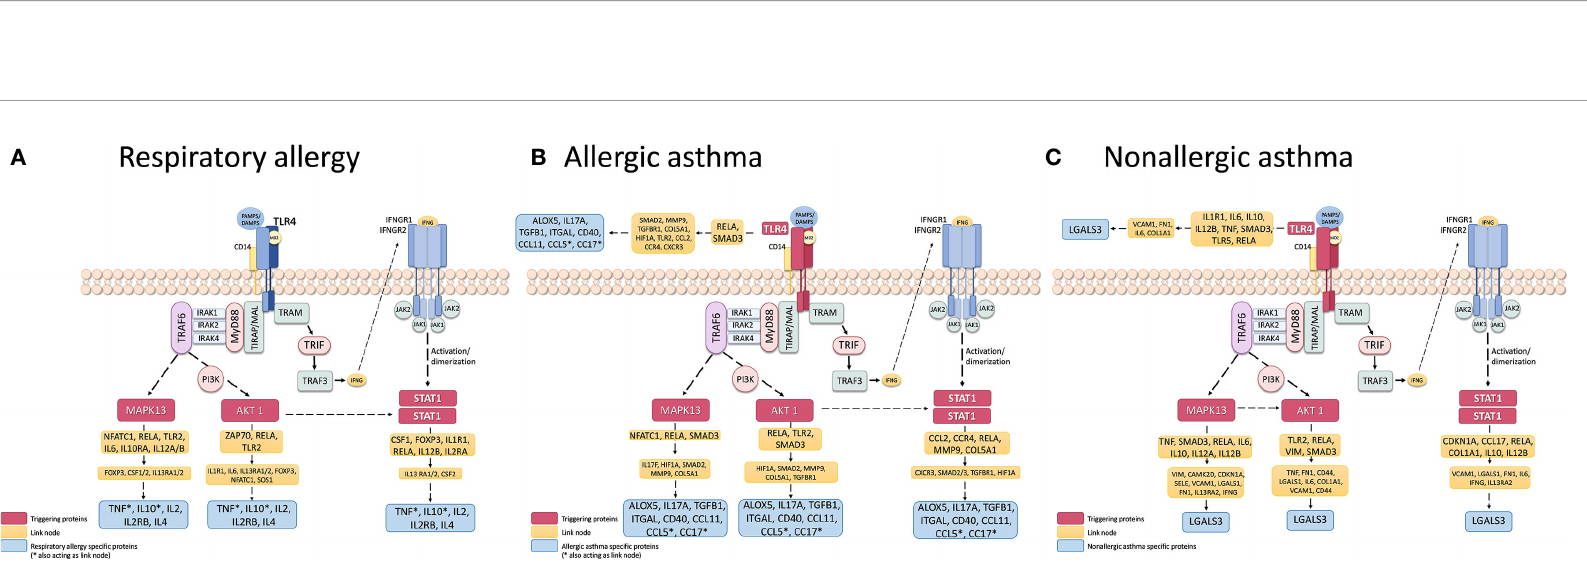
FIGURE 4 | Schematic representation of the triggering protein-activation pathway for each disease, using as a target the protein de fi ned as mechanistically highly related to the disease. The proteins that link these pathways with proteins with high mechanistic value for this speci fi c disease appear in yellow. Supplementary Figure 1 represents the pathway scheme obtained by Pathlinker analysis using the Cytoscape V3.6.1 (https://cytoscape.org/) program. (A) Respiratory Allergy. (B) Allergic Asthma. (C) Non-allergic